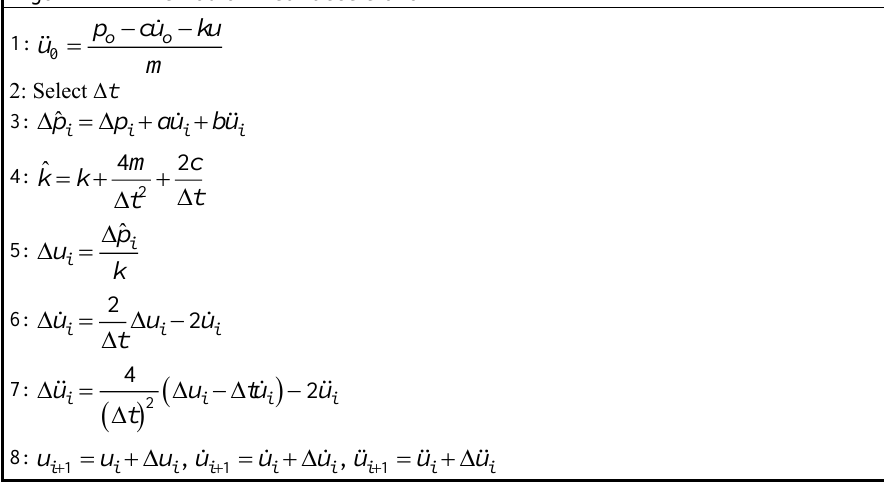
Algorithm 2 - Method of linear